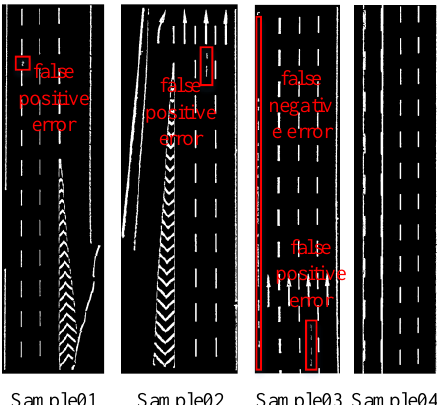
Figure 10. Extracted marking of sample area